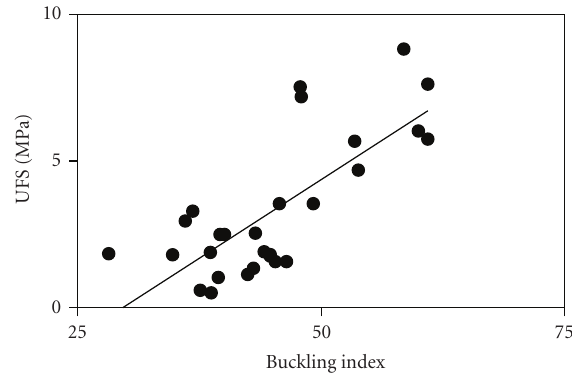
Table 3: Multiple regression analysis with r 2 selection, with Buck- ling index as the independent variable.